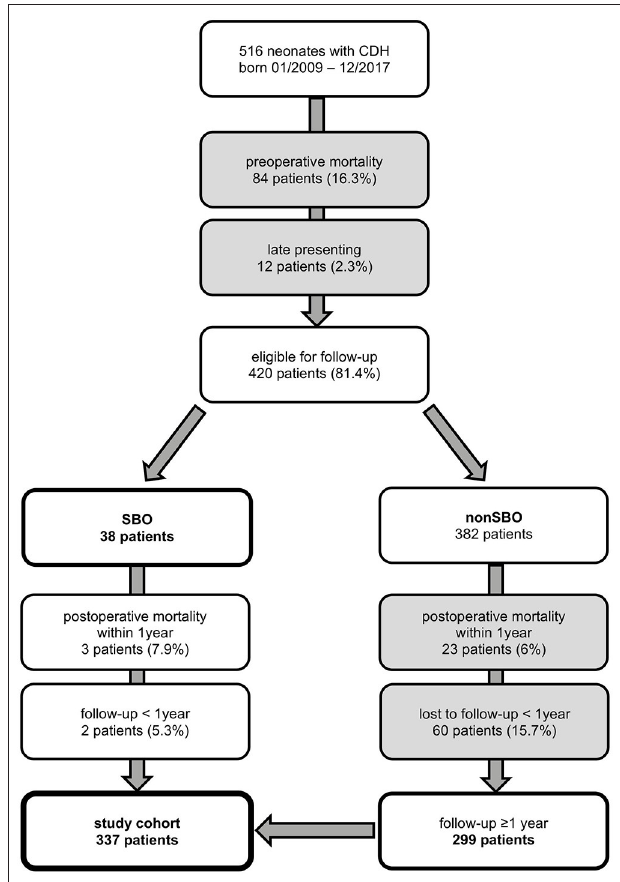
FIGURE 1 | Neonates with congenital diaphragmatic hernia (CDH) born from January 2009 to December 2017 and treated at our institution and participation at follow-up until October 2019 with excluded patients in gray boxes [SBO = small bowel obstruction].